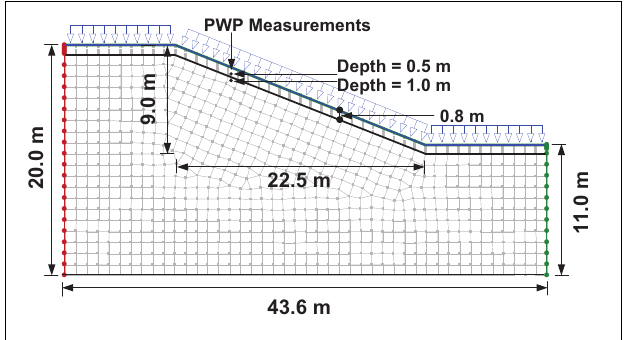
FIGURE 5 | Model slope for numerical